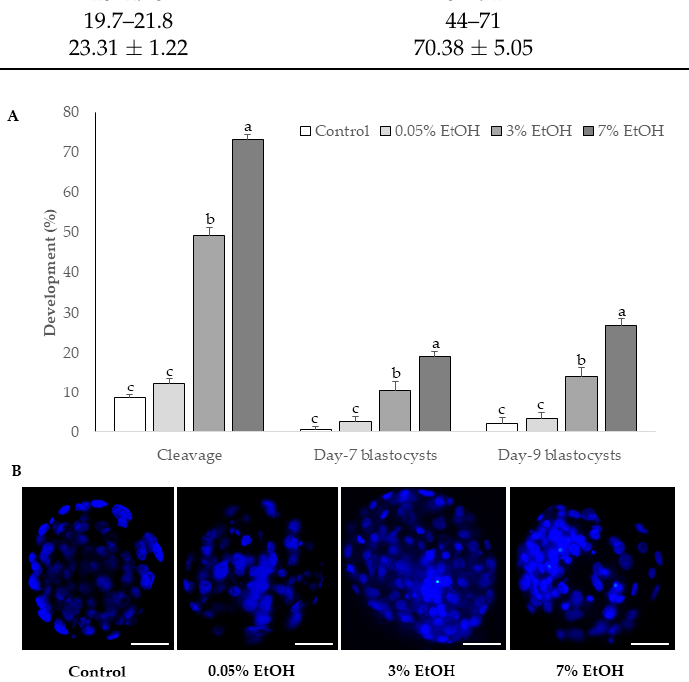
Figure 1. Effect of ethanol concentration on bovine oocyte parthenogenetic activation. ( A ) Percentage (% ± s.e.m) of cleavage (day 3), blastocysts’ development (day 7 and 9), and ( B ) blastomere nuclei stained with Hoechst in parthenogenic embryos derived from bovine oocytes matured without (control) or with 0.05% ethanol for 24 h or activated with 3% or 7% ethanol for 7 min. The white bar represents the 50 μ m mark. Different letters above each bar indicate statistical significance ( p < 0.05). Table 4. Percentages (% ± s.e.m.) of mature (metaphase II, immature and degenerate) and fertilized (total, normal, polyspermic, asynchronous and not fertilized) bovine oocytes collected in summer and in vitro matured in absence (control and 0.05% ethanol) or presence of α -tocopherol at 50 ( α -50), 100 ( α -100) and 200 ( α -200) μ M.